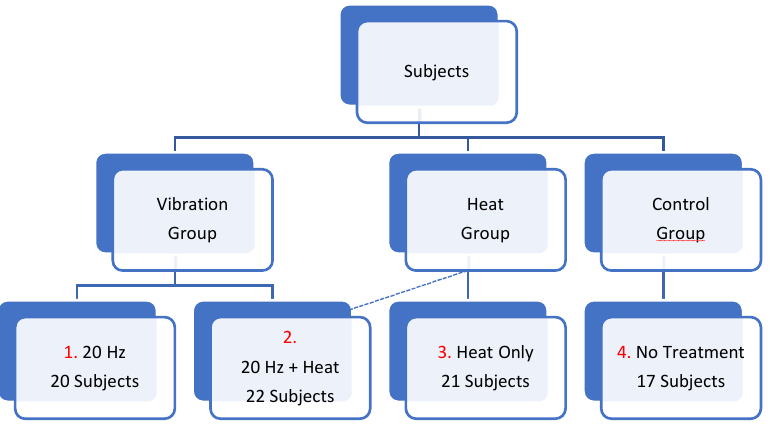
Figure 3. Participant group assignment.